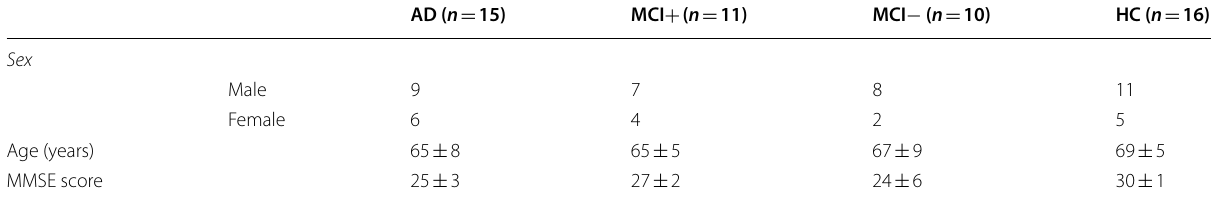
Table 1 Demographic characteristics of the